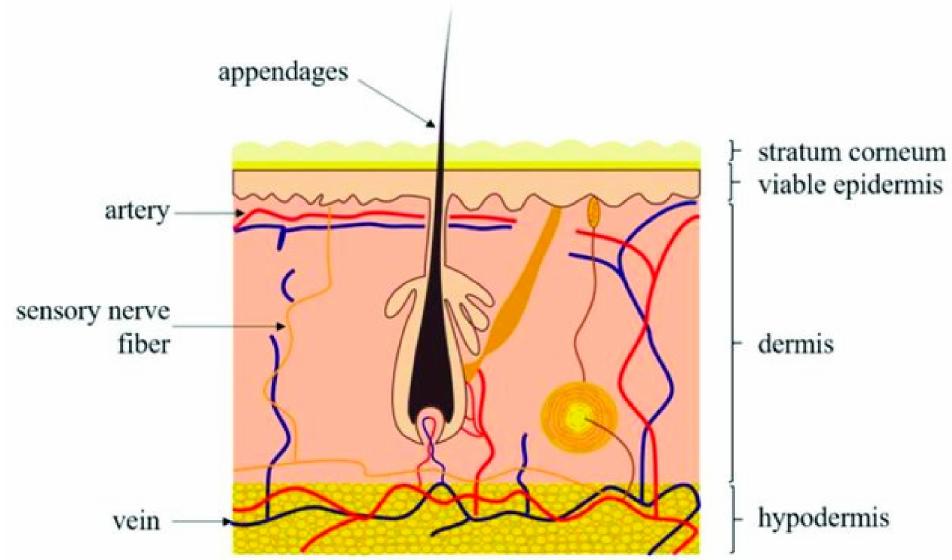
Figure 1. Sketch of human skin with visible three layers of the skin—from the outside to the inside: the stratum corneum (the outmost layer), epidermis, dermis, and hypodermis. Reproduced with permission from